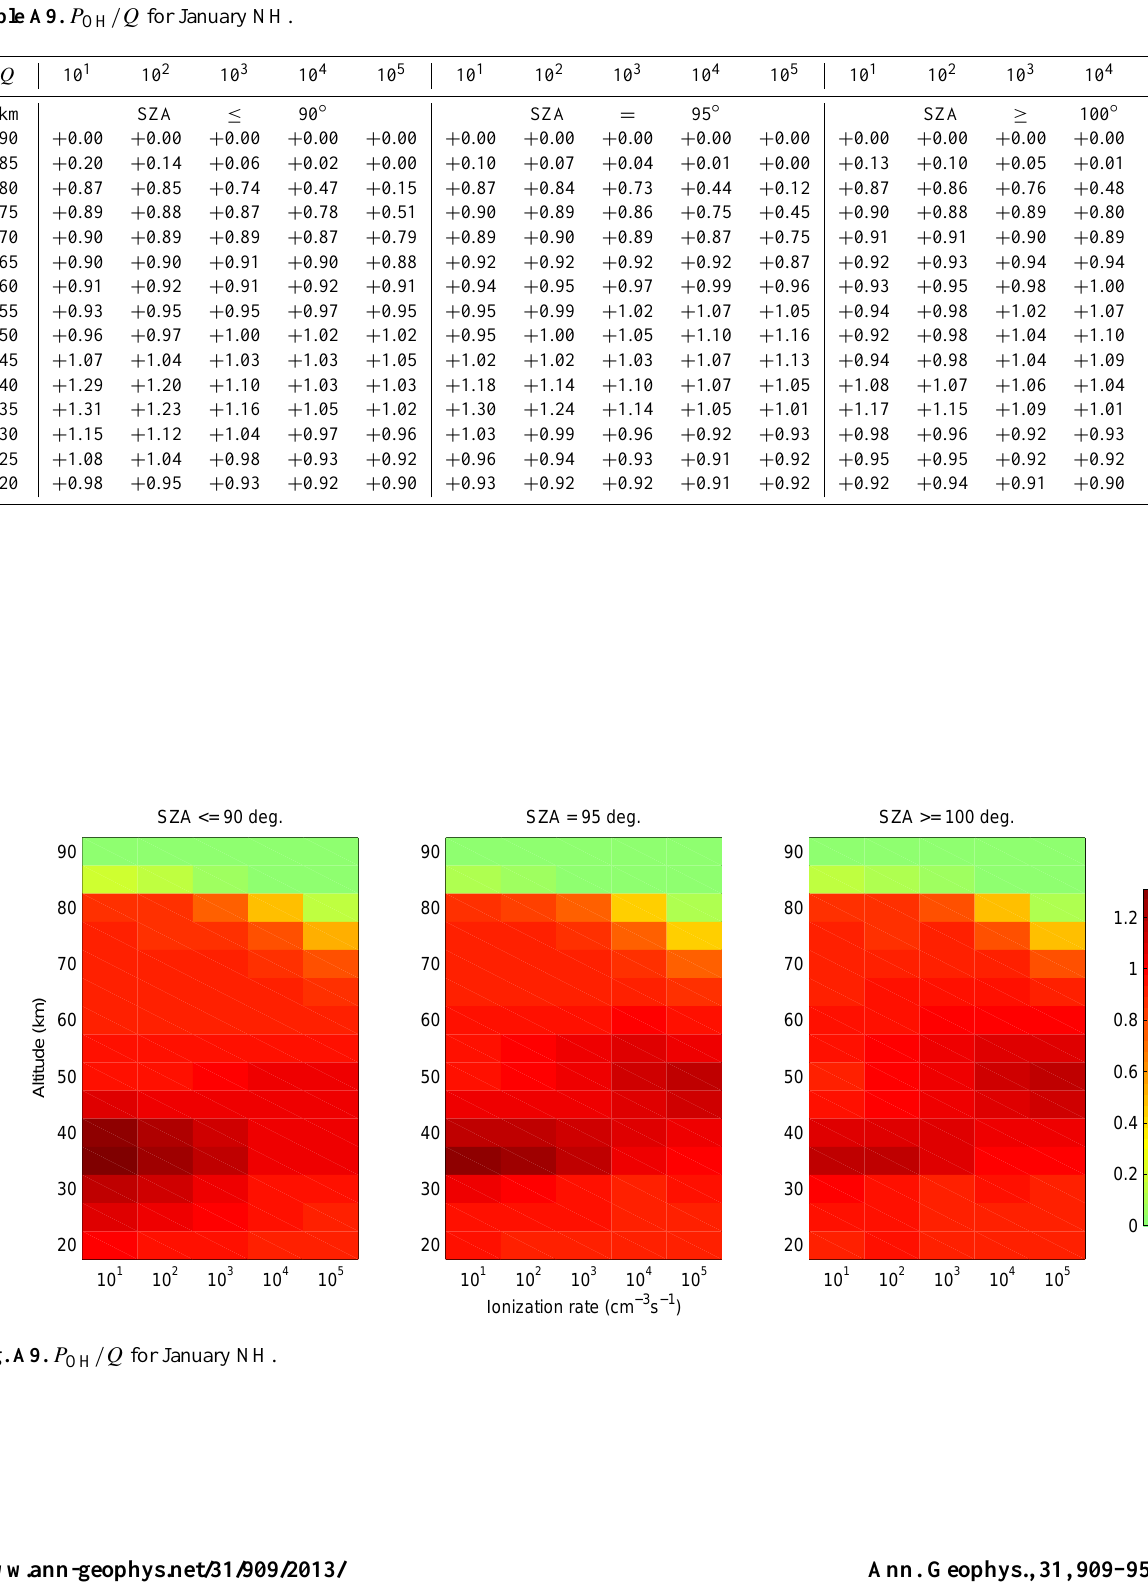
Table A9. P OH /Q for January NH.